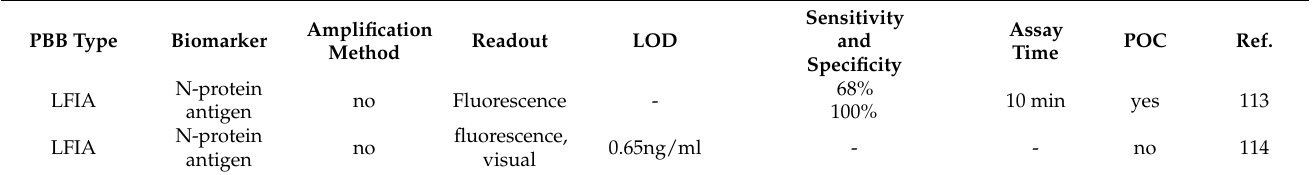
Table 2. SARS-CoV-2 antigen detection